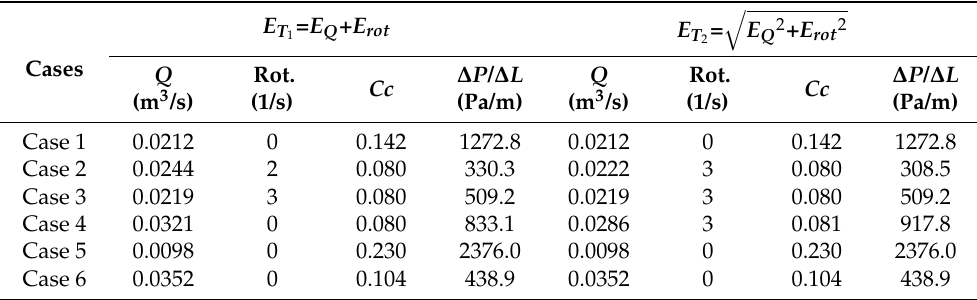
Table 5. Optimal flow rate and pipe rotation speeds when the cutoff cuttings concentration is selected as 8%.